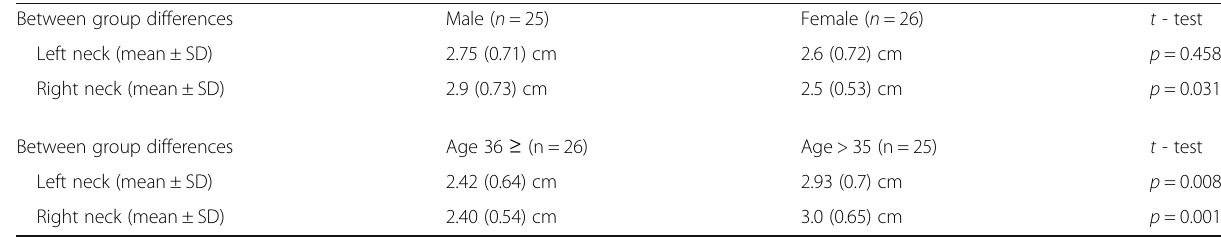
Table 1 TPD thresholds for male and female as well as younger and older participants (intra-rater reliability sample) Between group